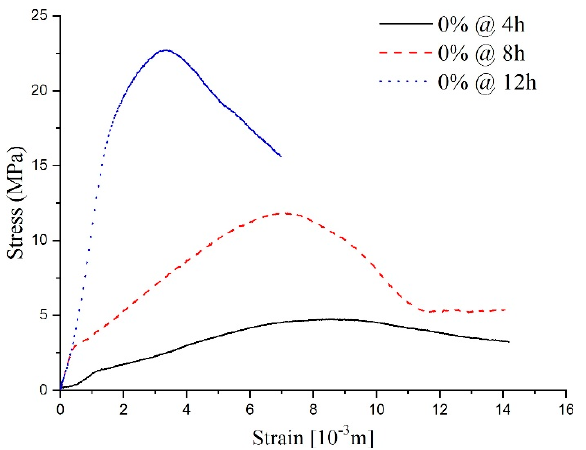
Figure 10. The stress–strain curve for the samples without sulfate attack. According to the fourth stage’s stress–strain curve analysis, samples with a 12-h curing age conformed to the ideal elasto-brittle model. After the sample deformation reached the peak point, the sample’s strength experienced a sudden drop to the residual value [25]. For the samples with an 8-h curing age, the curves’ first three stages were the same as the typical stress–strain curve; however, the fourth stage revealed some characteristics of the strain-softening model, one of which being that strength degrades with an increase in the main plastic strain in the post-peak stage. Concerning the shorter sample ages, like the 4 h samples, due to the low completion degree of the hydration process, the dispersion of the stress–strain curve reflects the heterogeneity of the specimen. Thus, the stress–strain curve had some erratic disturbances in the first three stages compared with the typical stress–strain curve. Nevertheless, a conspicuous strength peak could be observed, and the post-peak strength changed slowly as the strain increased. This is to say, that the characteristics in the fourth stage conform to a relatively ideal elastic-plastic model.